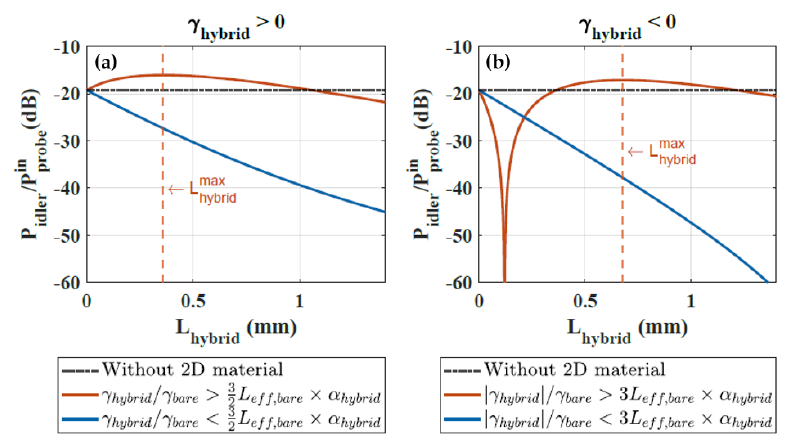
Figure 6. Idler power output divided by probe input power versus the 2D material length for ( a ) positive values of γ hybrid with γ hybrid / γ bare = 100 (orange) and γ hybrid / γ bare = 5 (blue), and ( b ) taking negative values of γ hybrid with γ hybrid / γ bare = − 120 (orange) and γ hybrid / γ bare = − 1 (blue). In both cases, L ef f , bare × α hybrid = 32 and the dotted black line at − 20dB corresponds to the idler generated without 2D material on the waveguide. The pump power is